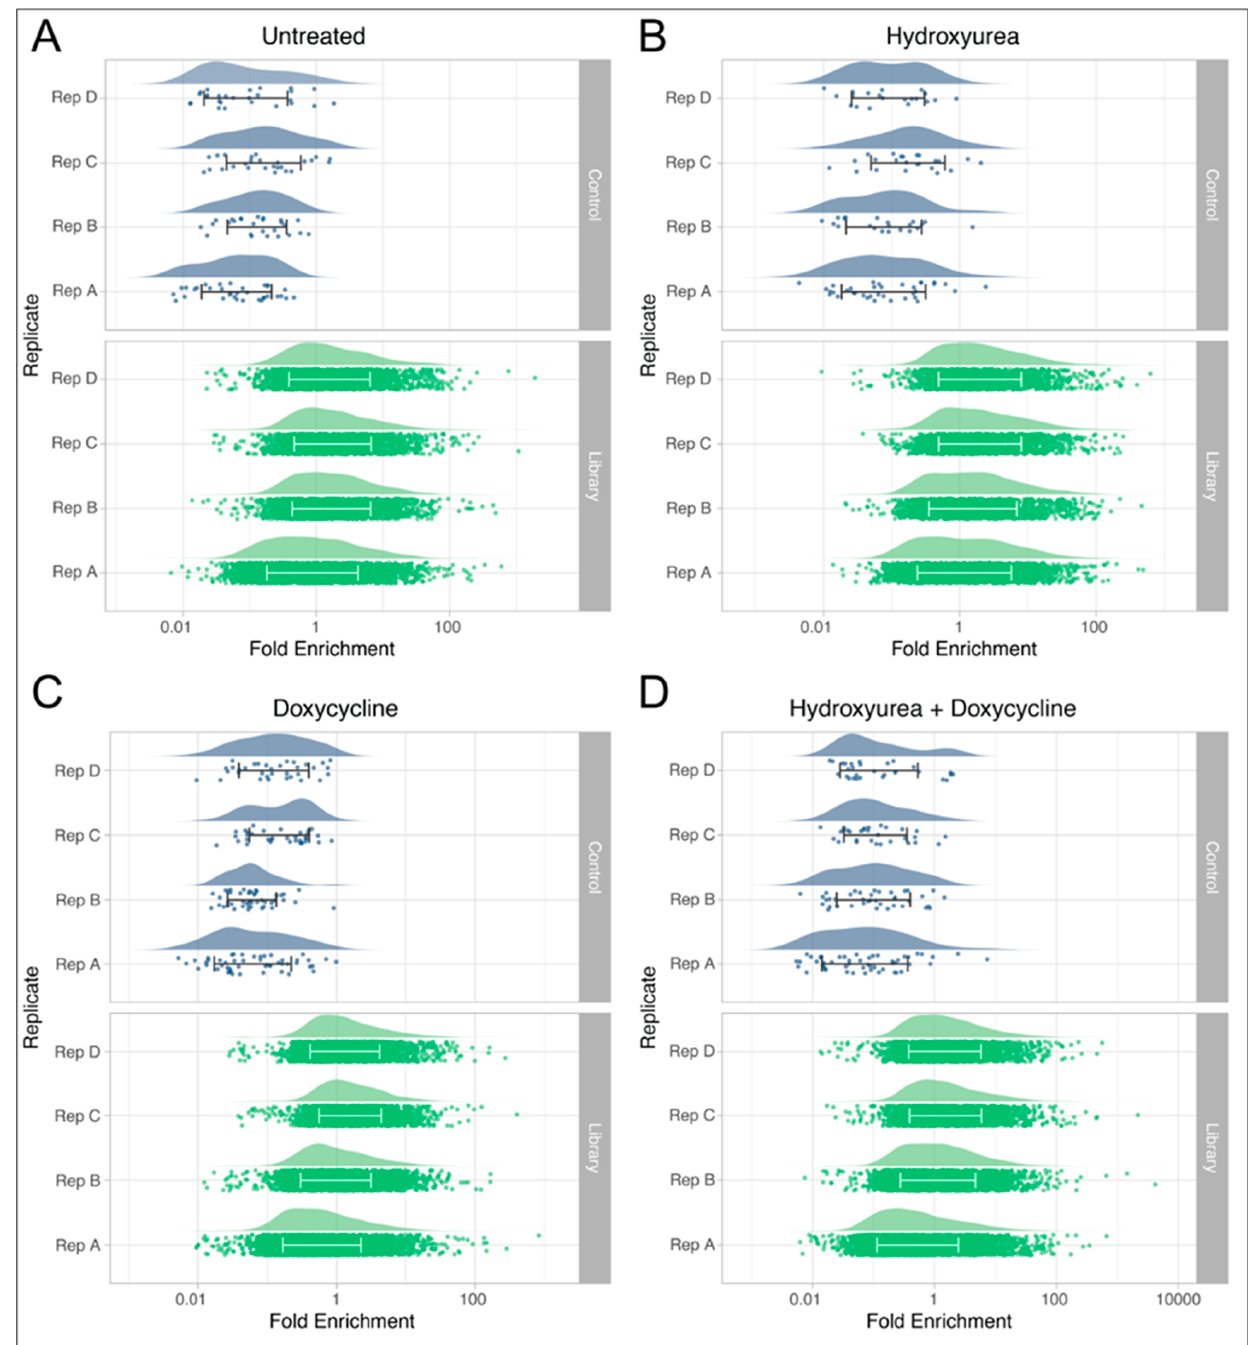
Figure 2. shRNA enrichment. shRNA enrichment over input for each replicate and each treatment following selection for ganciclovir resistance in DF/myc(CTG) 100 eGFP/TK cells, including non-targeting shRNA controls (upper panels) and the gene-targeting shRNA library (lower panels). The distribution of data for each replicate sample is shown above the bee swarm of individual data points. Within the swarm, the bars span from one standard deviation below to one standard deviation above the mean values for fold enrichment. ( A ) Control (untreated); ( B ) hydroxyurea; ( C ) doxycycline; and ( D ) hydroxyurea plus doxycycline treatments are as indicated. A total of 5200 unique shRNA hits are represented in Figure 3, representing approx- imately 3.4% of the input shRNAs. The candidate loci identified in each of the four types of treatment were compared (Figure 3A) (tabulated in Supplementary Table S3). While